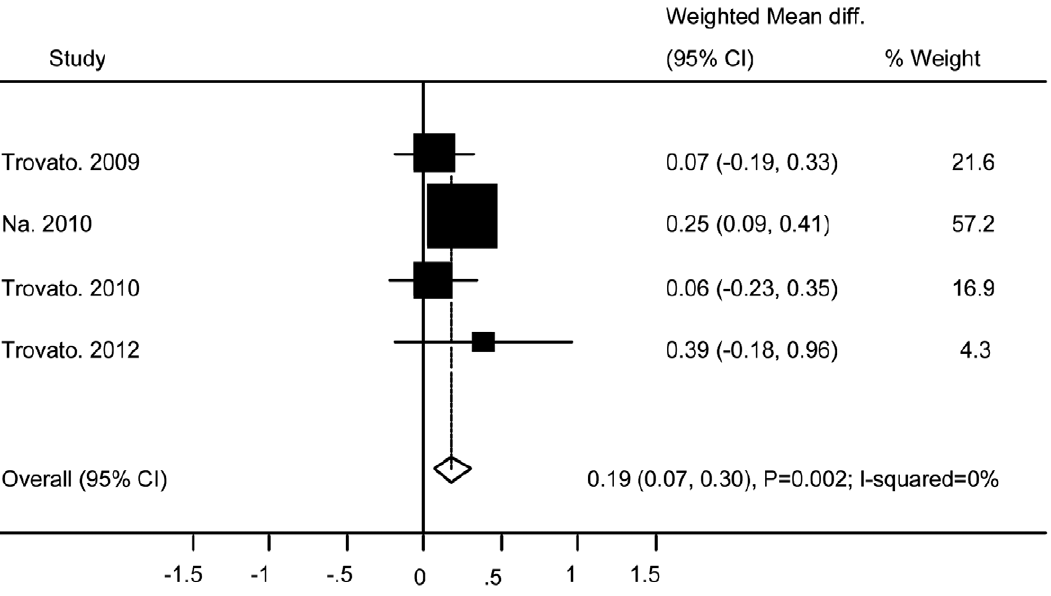
Figure 10. Association of Ad36 with Low Density Lipoprotein.